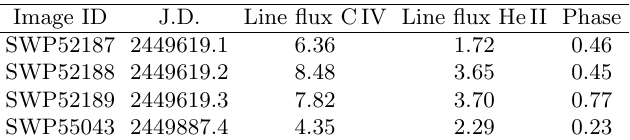
Fig. 11. Variation of the C IV line (cid:13)ux with phase for AN UMa. The 1 (cid:27) error bars are shown on each data point. The (cid:13)ux is plotted in units of erg cm (cid:0) 2 s (cid:0) 1 . Table 5. Line (cid:13)uxes of HU Aqr from the IUE spectra. The integrated (cid:13)uxes are in units of 10 (cid:0) 13 erg cm (cid:0) 2 s (cid:0) 1